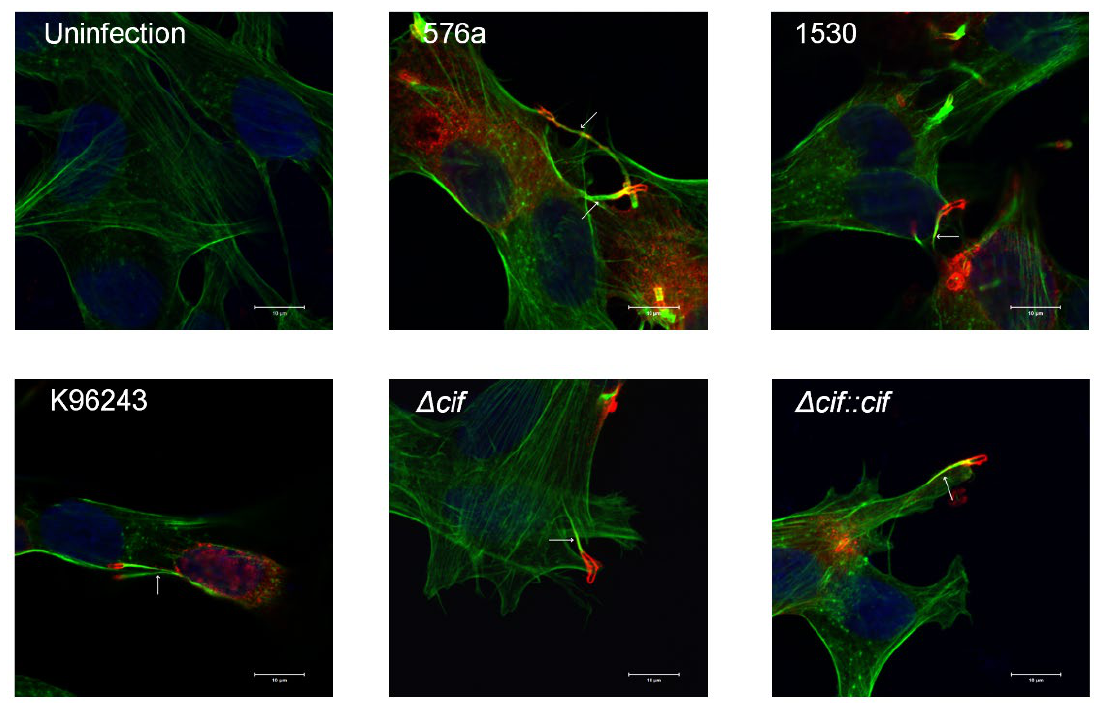
Figure 4. Actin-tails of B. pseudomallei strains in SH-SY5Y cells. SH-SY5Y cells infected with B. pseu- domallei K96243, 576a, 1530, cif -deletion, and cif complemented strains. At 6 h post-infection, the infected cells were stained to detect actin-tails. Actin-tails in SH-SY5Y cells were examined by direct immunofluorescence staining with Alexa Fluor488-conjugated phalloidin (green) and DNA was stained using Hoechst 33258 (blue). Bacteria were stained using mouse monoclonal anti- B. pseudo- mallei lipopolysaccharide antibody and detected with Alexa Fluor555-conjugated phalloidin (red). Scale bar = 10 μm.